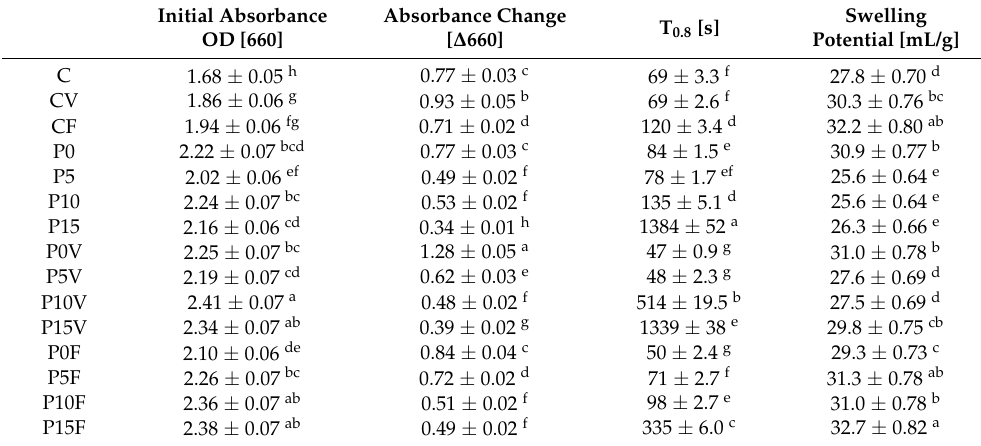
Table 2. Parameters of the stability of the